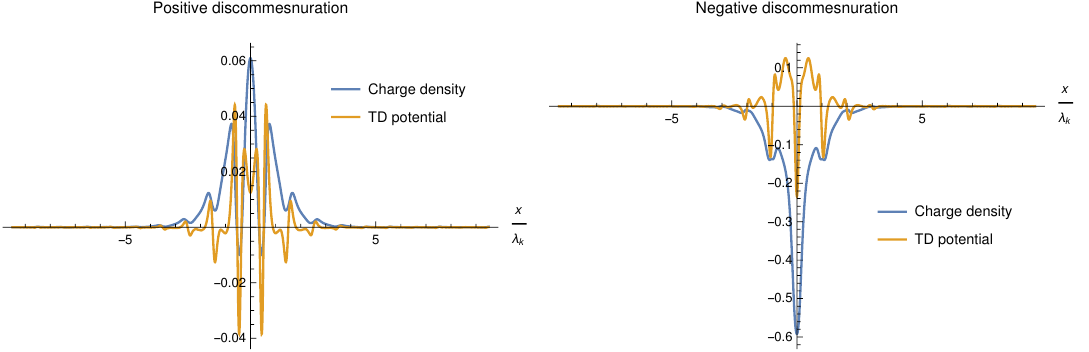
Figure 4 . Charge and thermodynamic potential of a discommensuration measured with respect to the parent commensurate state. The distributions clearly show that the discommensuration is a local object. The positive disc. is considered at A = 1, the negative | at A = 2. The charge is manifestly positive for positive disc. and manifestly negative for negative one, in analogy with the toy model.